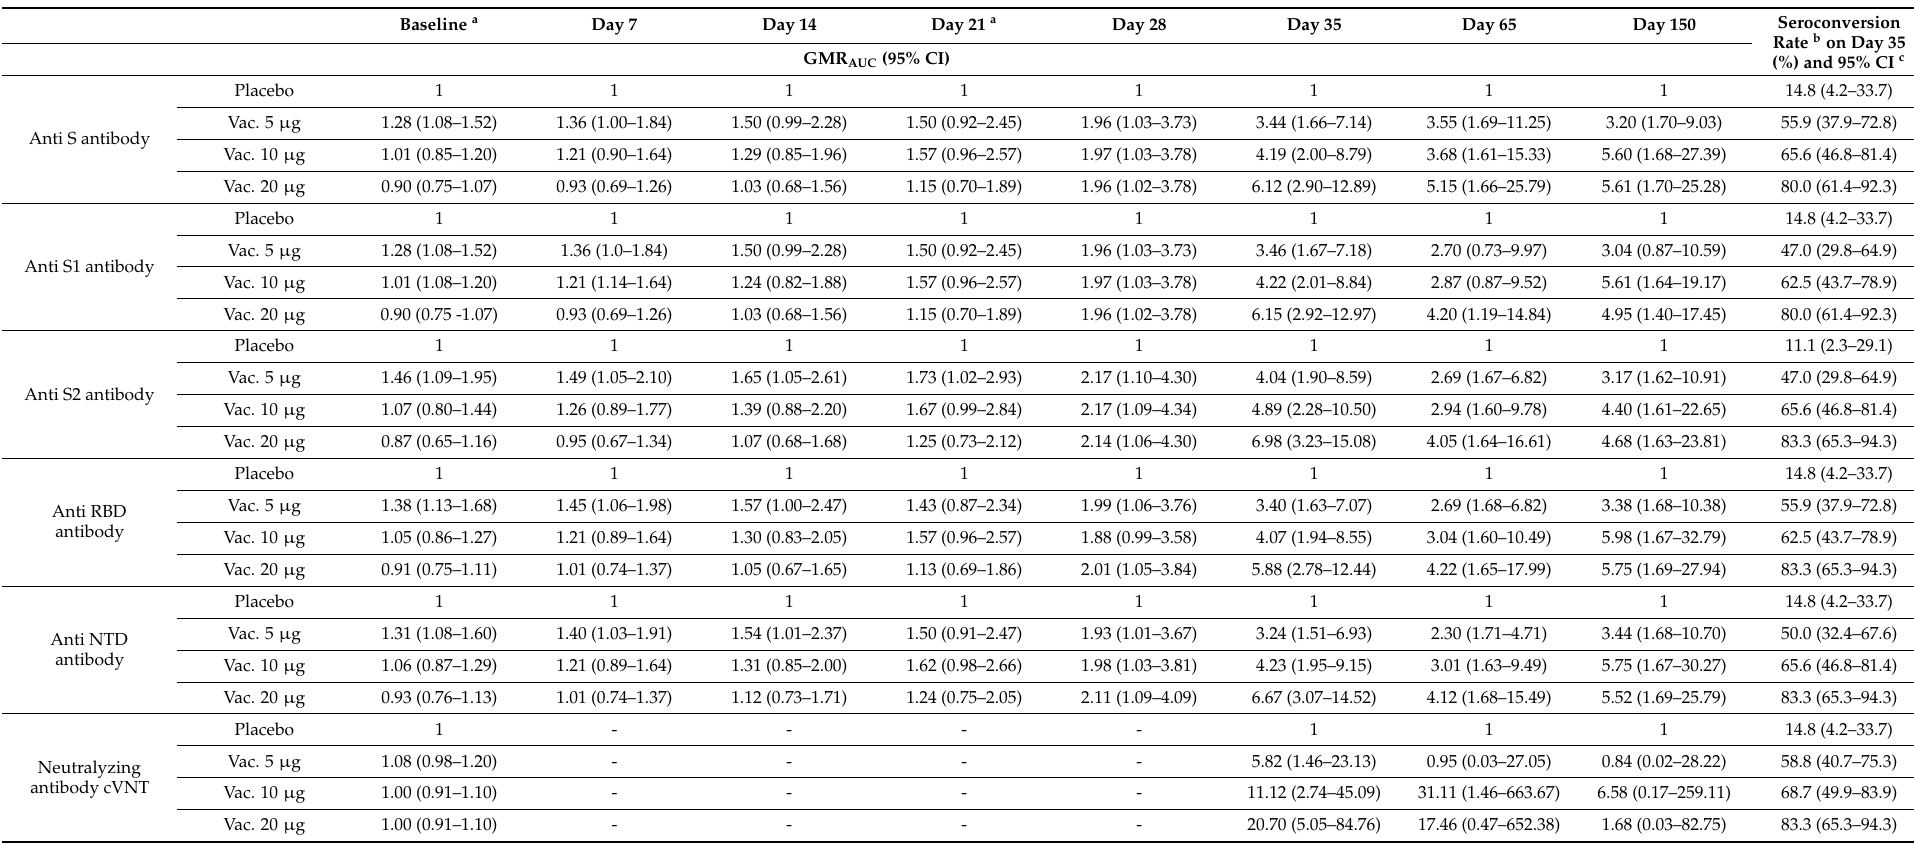
Table 3. Geometric mean ratio and 95% CI of specific antibody responses (AUC) to S, S1, S2, RBD, and NTD antigens (measured using ELIZA) and neutralizing antibody response (measured using cVNT) in the intervention groups over the predefined study time schedule. Baseline